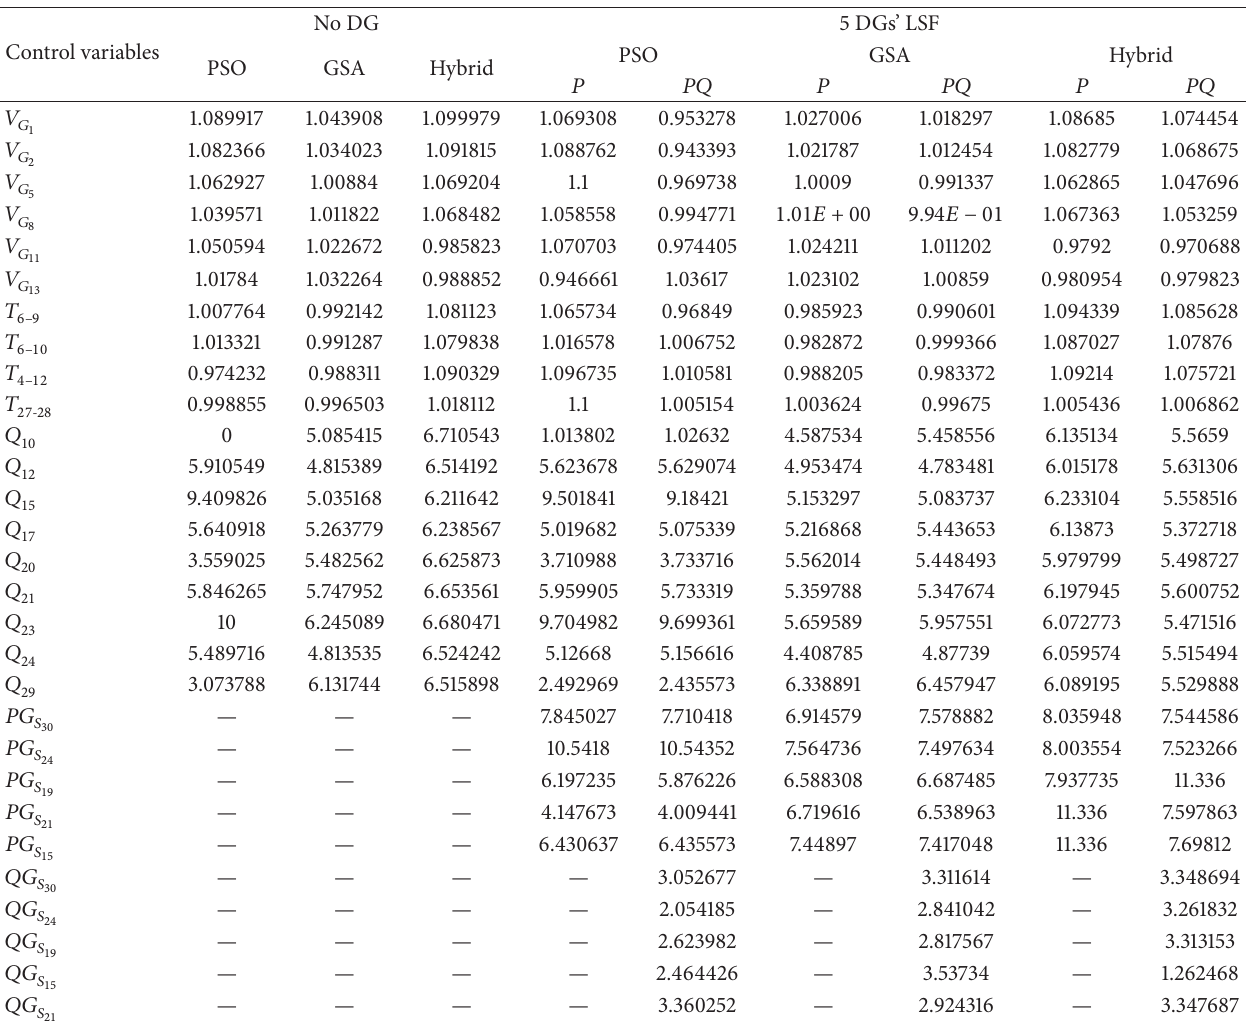
Table 4: Optimal values obtained for best result